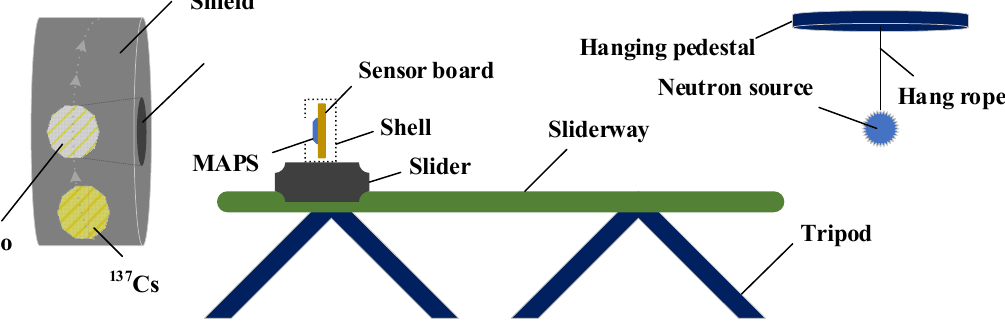
Figure 1. Experimental setup: the collimated 60 Co and 137 Cs sources; the isotropic Am-Be and 252 Cf sources. Table 1. Experimental scheme.